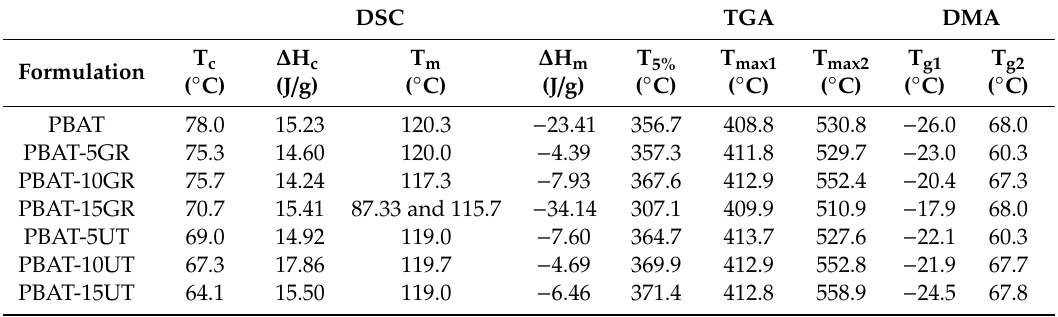
Table 1. Thermal properties of neat PBAT and PBAT-resin-based formulations in 5, 10, and 15 wt.%.